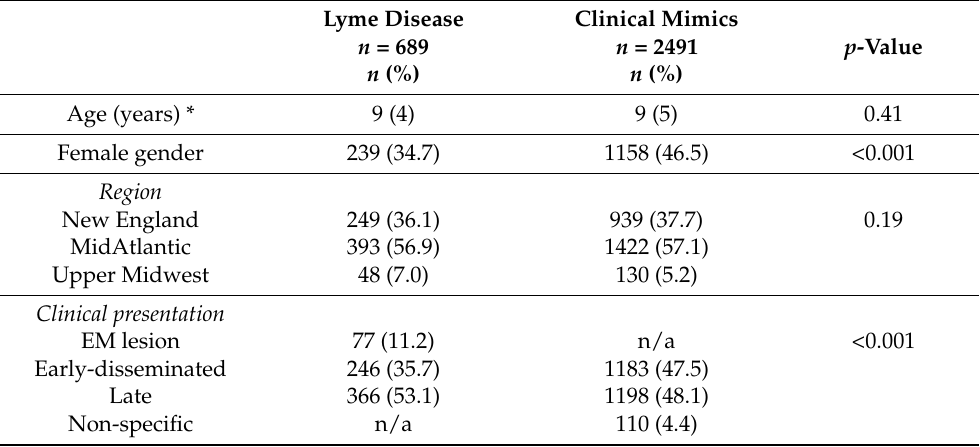
Table 1. Comparison of clinical characteristics for children with Lyme disease versus clinical mimics.